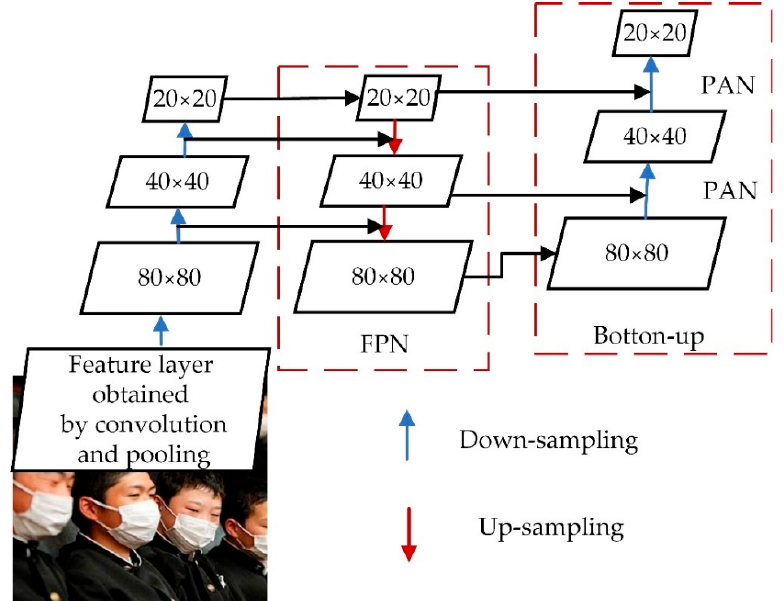
Figure 6. Neck structure diagram.